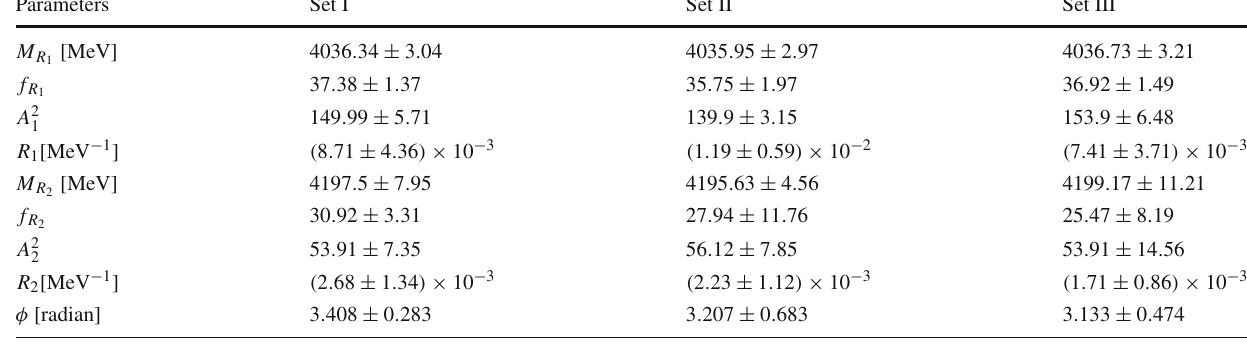
Table 2 Three sets of fit data for nine parameters Parameters